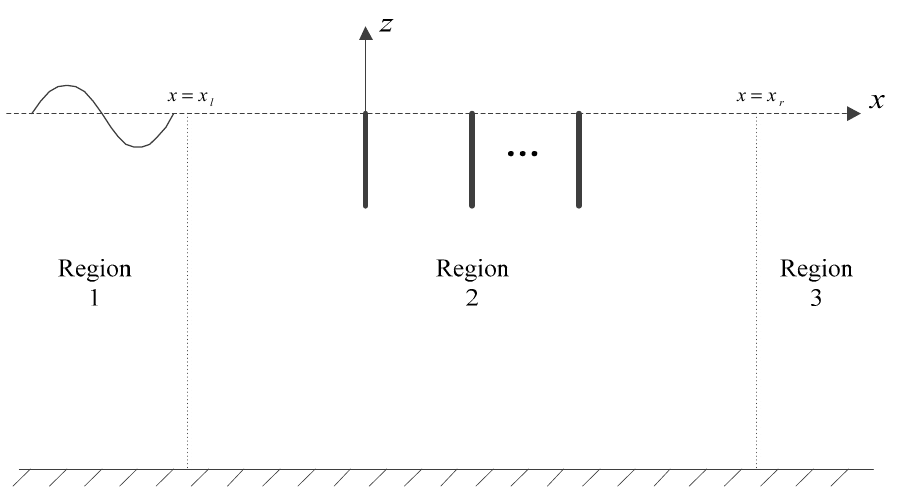
Figure 2. Division of flow field region.